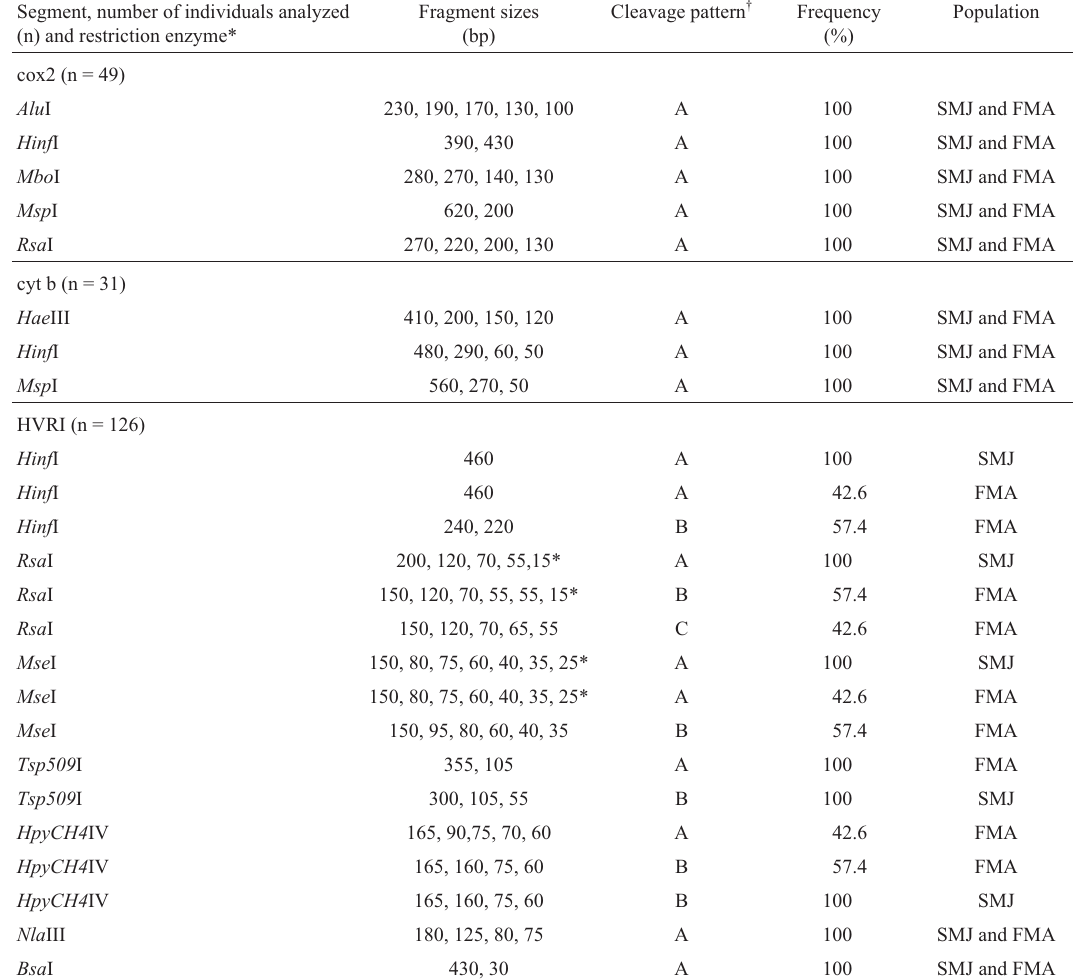
Table 1 - Restriction enzyme cleavage patterns of the genes c ytochrome c oxidase subunit 2 ( cox2 , 820 bp), cytochrome b ( cyt b , 880 bp) and the hypervariable segment of mtDNA control region (HVRI, 460 bp) of the Brachyteles hypoxanthus populations from Santa Maria de Jetibá in the Brazilian state of Espírito Santo (SMJ population, n = 18) and Feliciano Miguel Abdala in the Brazilian state of Minas Gerais (FMA population, n = 108). The total number (n) of muriquis analyzed for each mtDNA segment is shown in parentheses in the first column. Segment, number of individuals analyzed (n) and restriction